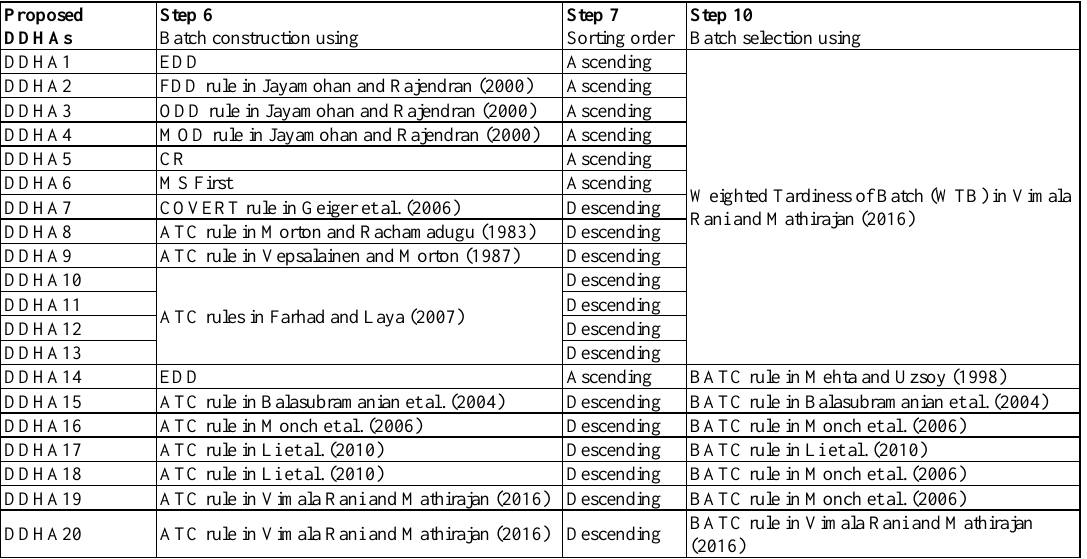
Table 1. Modified steps in proposed 20 variants of